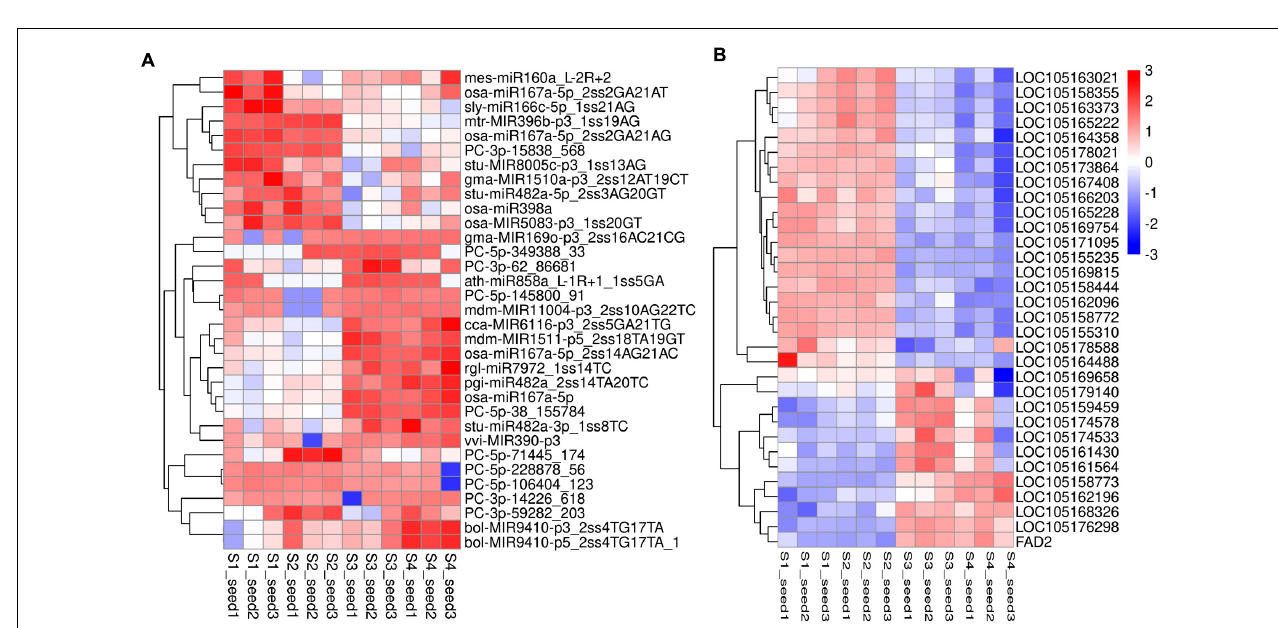
FIGURE 5 | Analysis of (A) enriched GO and (B) KEGG of miRNAs and target genes in different seed development periods of sesame.